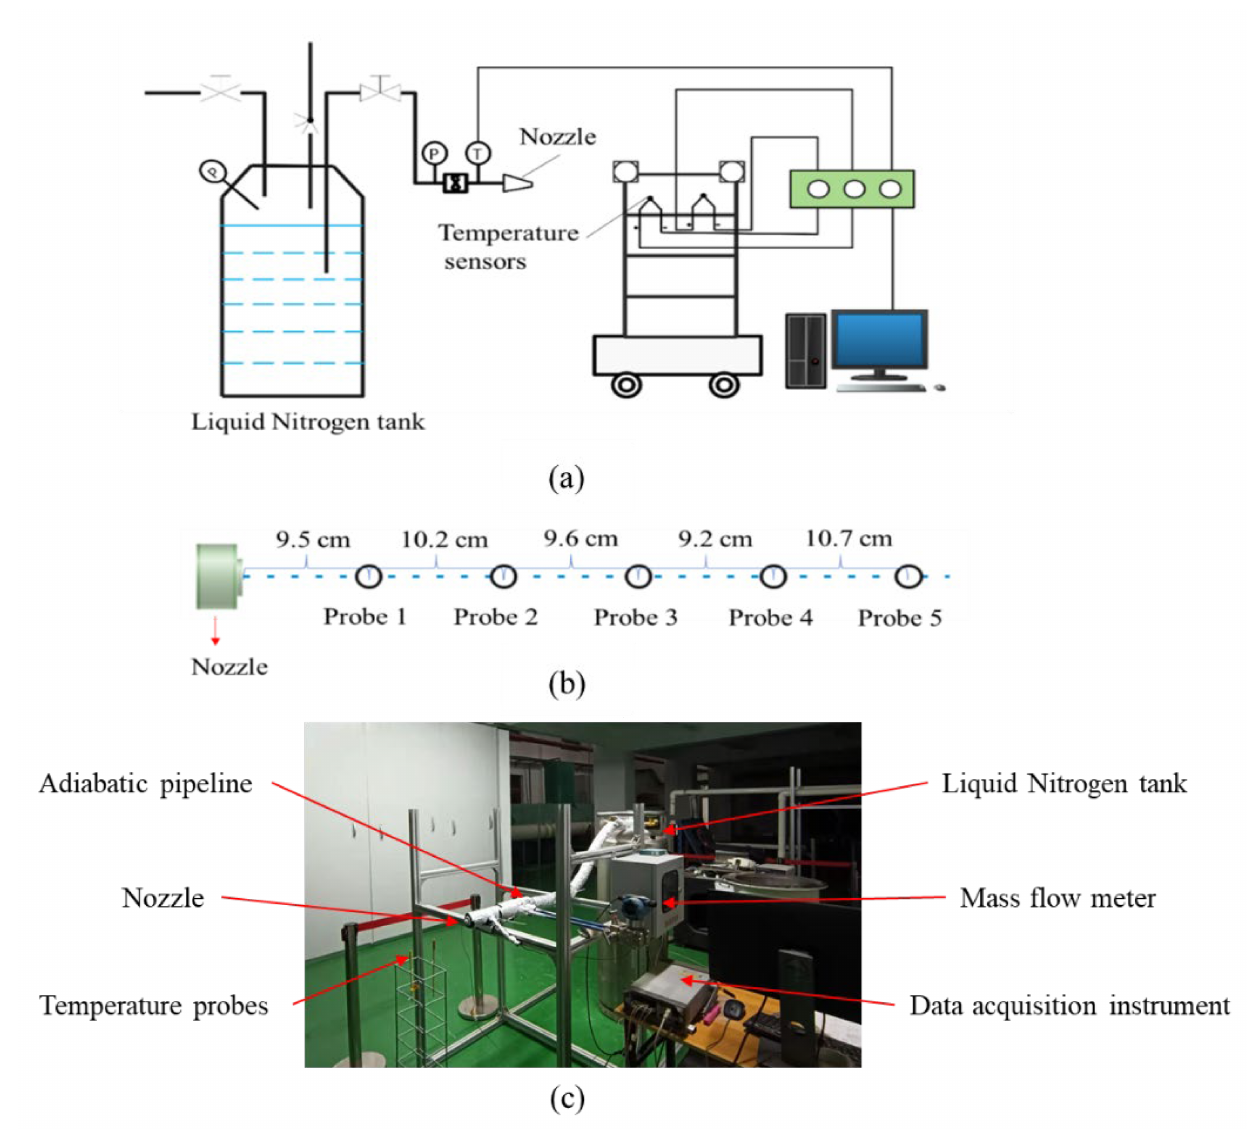
Figure 3. Schematic and physical diagram of test rig. ( a ) schematic diagram, ( b ) temperature measurement distribution, ( c ) picture of the test